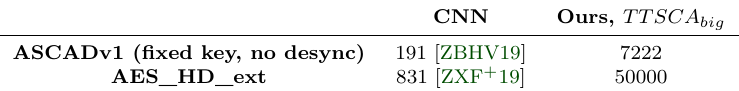
Table 7: DLSCA benchmark of ¯ NT GE value depending on